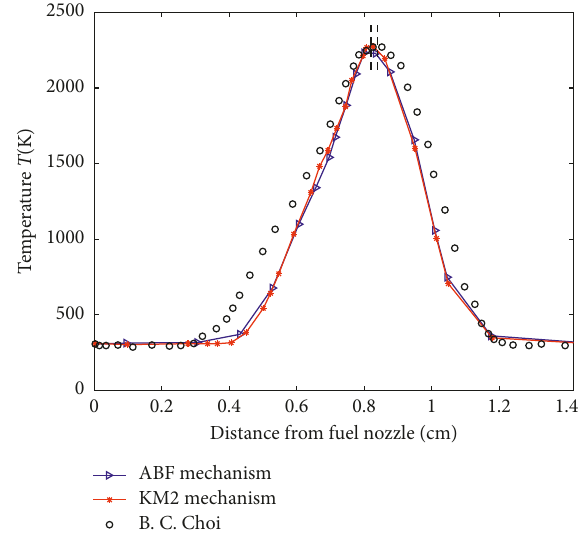
Figure 3: Temperature profile. Circles are measurement data from